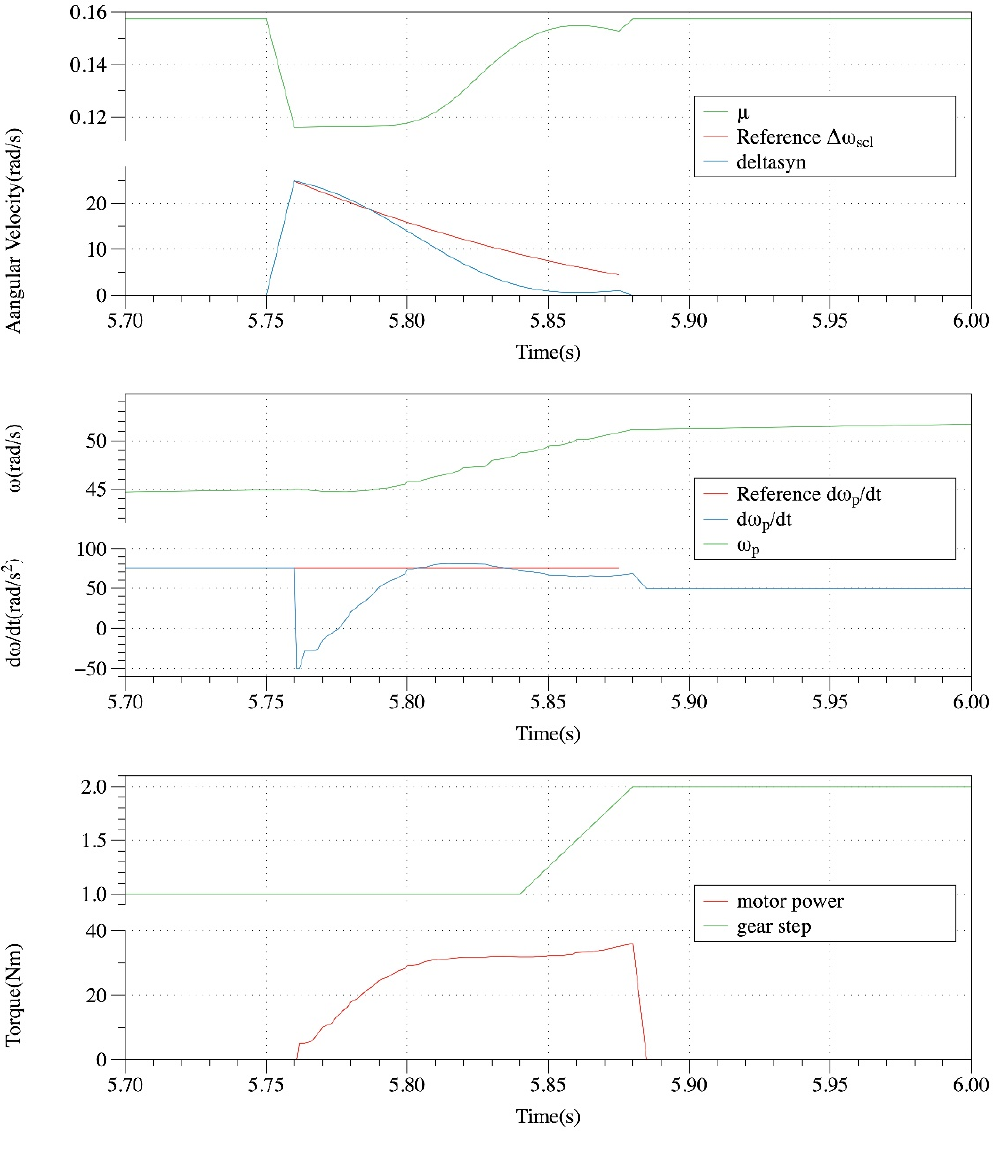
Figure 18. The shifting performance with θ = 15 ◦ and change of µ well estimated.